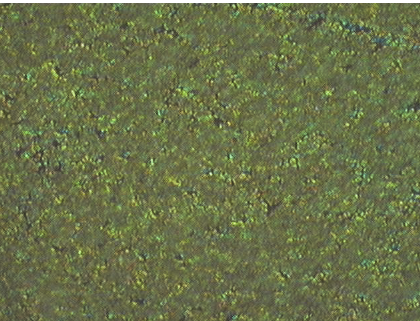
Figure 4: Optical picture of a CeO 2 /5% MMT nanocomposite film deposited under potentiostatic conditions at 𝐸 = 1.10V, 25 ∘ C, and magnification, × 800.